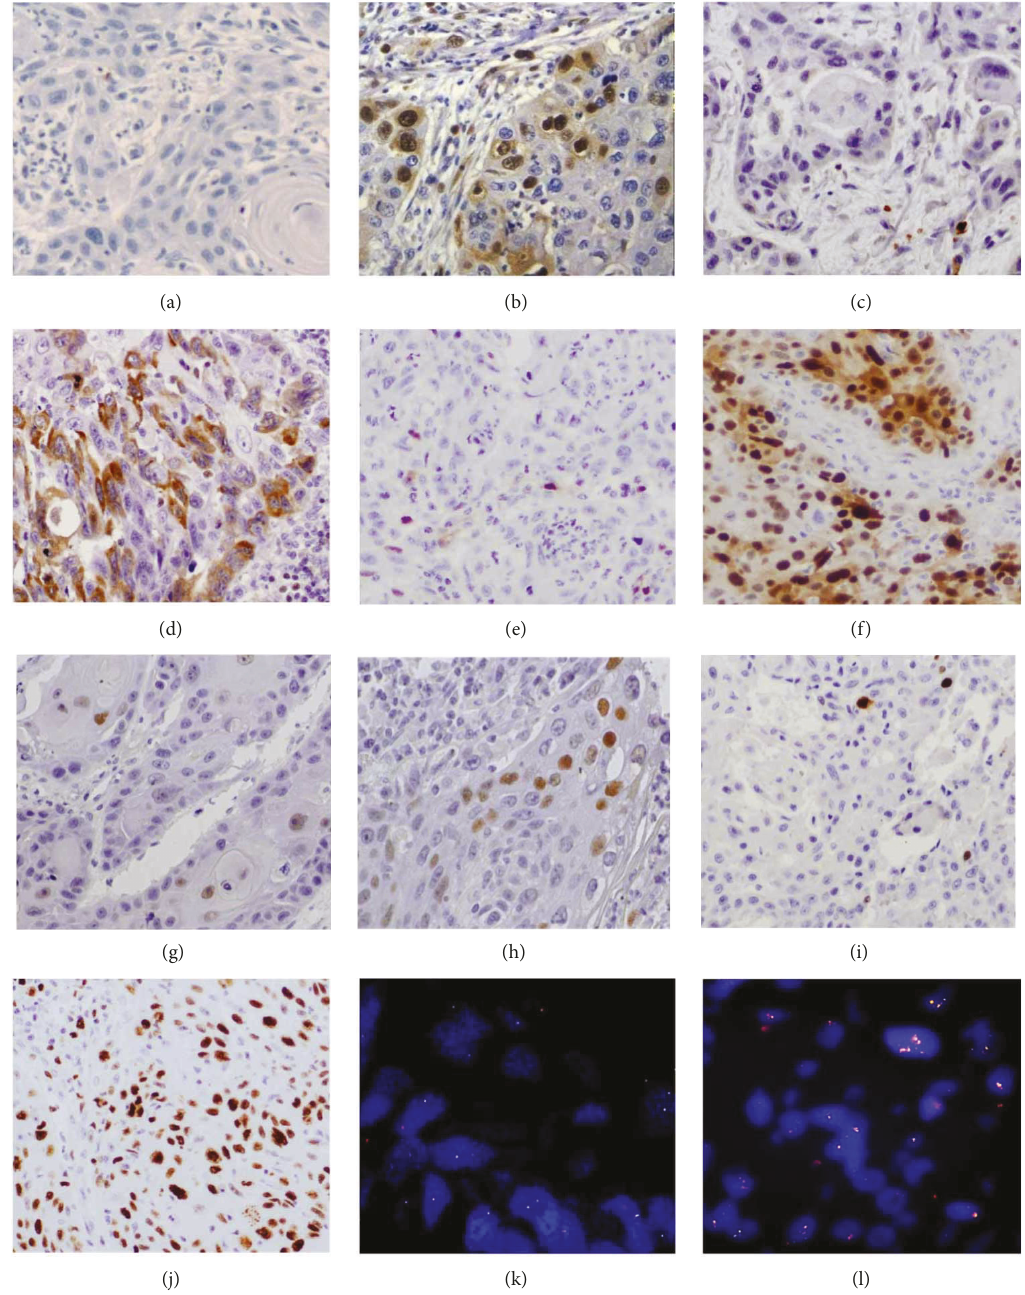
Figure 1: Immunohistochemical staining of cyclins and CCND1 region analysis by fl uorescence in situ hybridization technique in OSCC. (a) Low expression for cyclin A2 (magni fi cation × 200). (b) High expression for cyclin A2 (magni fi cation × 200). (c) Low expression for cyclin B1 (magni fi cation × 200). (d) High expression for cyclin B1 (magni fi cation × 200). (e) Low expression for cyclin D1 (magni fi cation × 200). (f) High expression for cyclin D1 (magni fi cation × 200). (g) Low expression for cyclin E1 (magni fi cation × 200). (h) High expression for cyclin E1 (magni fi cation × 200). (i) Low expression for Ki-67 (magni fi cation × 200). (j) High expression for Ki-67 (magni fi cation × 200). (k) Normal CCND1 numerical signals (magni fi cation × 200). (l) Presence CCND1 numerical aberrations (magni fi cation ×